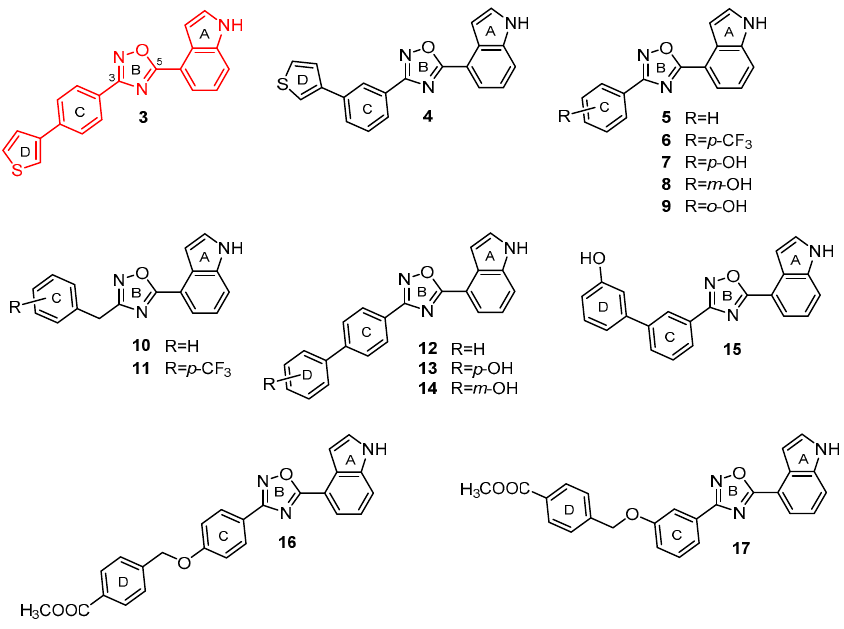
Figure 1. 1,2,4-oxadiazole derivatives generated in this study.